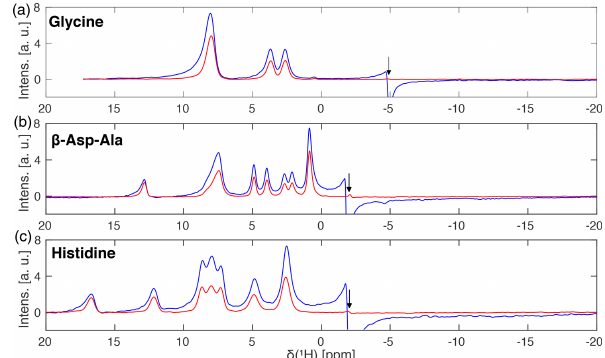
Figure 7. Frequency-switched Lee–Goldburg decoupled proton spectra of (a) natural-abundance glycine, (b) natural-abundance β -Asp-Ala and (c) natural-abundance L-histidine with (red) and without (blue) a 800µs I-BURP-2 pulse used to select the part of the rotor experiencing rf-field amplitudes close to the nominal value of 100kHz. Spectra were recorded at a proton resonance frequency of 500MHz using a 1.9mm Bruker MAS probe (com- pletely filled) spinning the sample at 14kHz. FSLG decoupling was achieved using a continuous phase ramp with a time reso- lution of 50ns and an effective field of 125kHz. The frequency axes are scaled by the experimentally determined scaling factors of (a) 0.562, (b) 0.557, and (c) 0.572, which are very close to the the- √ oretical one of cos( θ m ) = 1 / 3 ≈ 0 . 577. Arrows indicate the posi- tion of the carrier frequency. Narrower lines and a strongly reduced zero-frequency artefact are observed for spectra with a B 1 -field se-